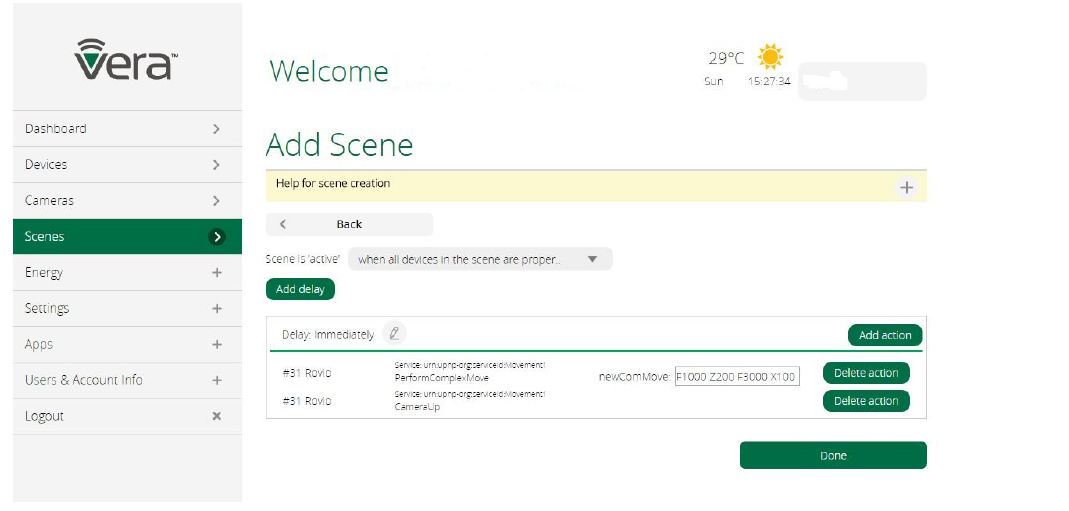
Figure 3. Scene section of Vera for the Rovio